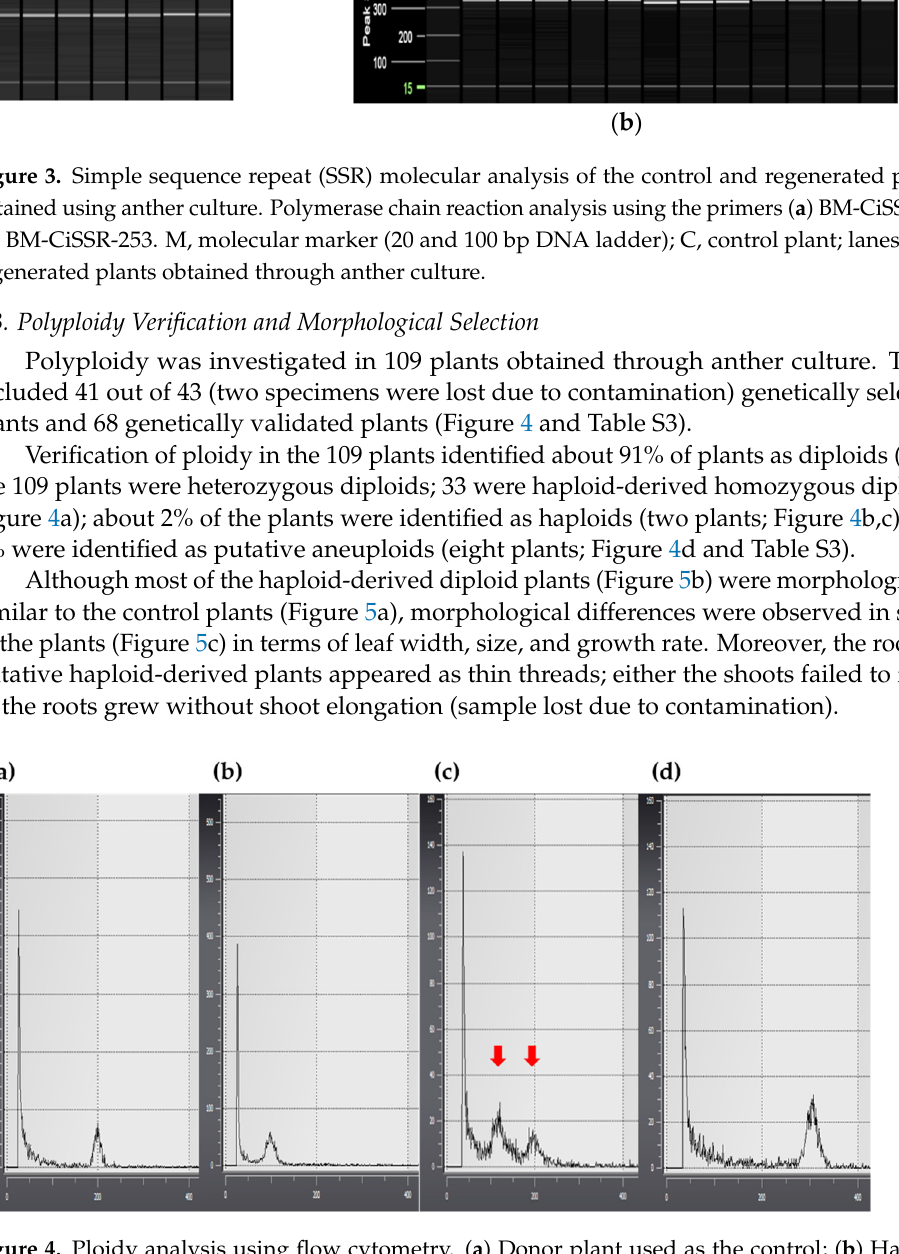
Figure 4. Ploidy analysis using flow cytometry. ( a ) Donor plant used as the control; ( b ) Haploid plants obtained through anther culture; ( c ) Mixed haploids and diploids obtained through anther culture; ( d ) Putative aneuploid plants obtained through anther culture. The red arrows indicate patterns associated with polyploidy.